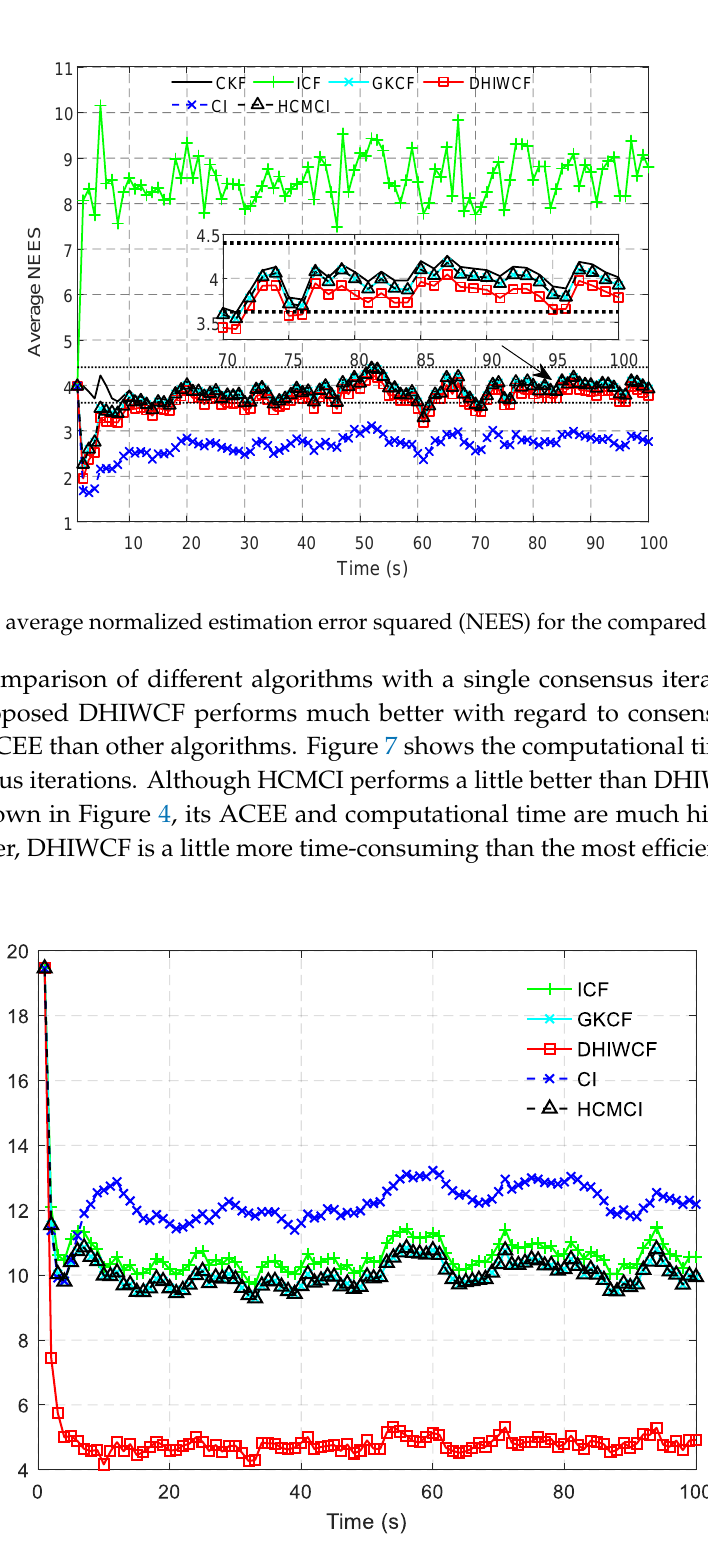
nodes, all time steps and all Monte Carlo runs.